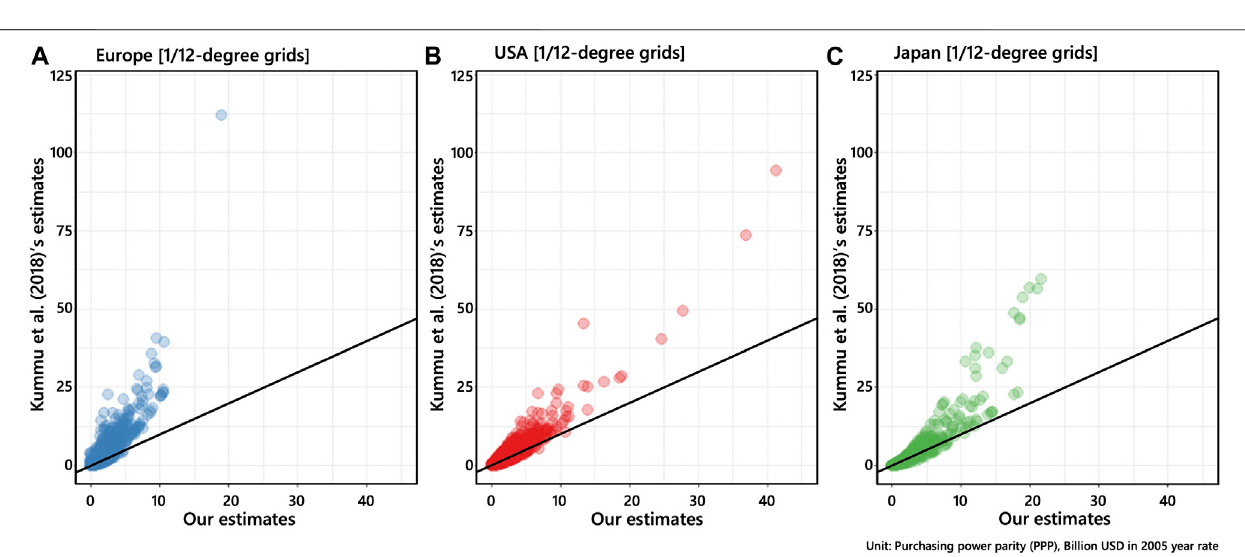
FIGURE 4 | Comparison of our GDP estimates with Kummu et al